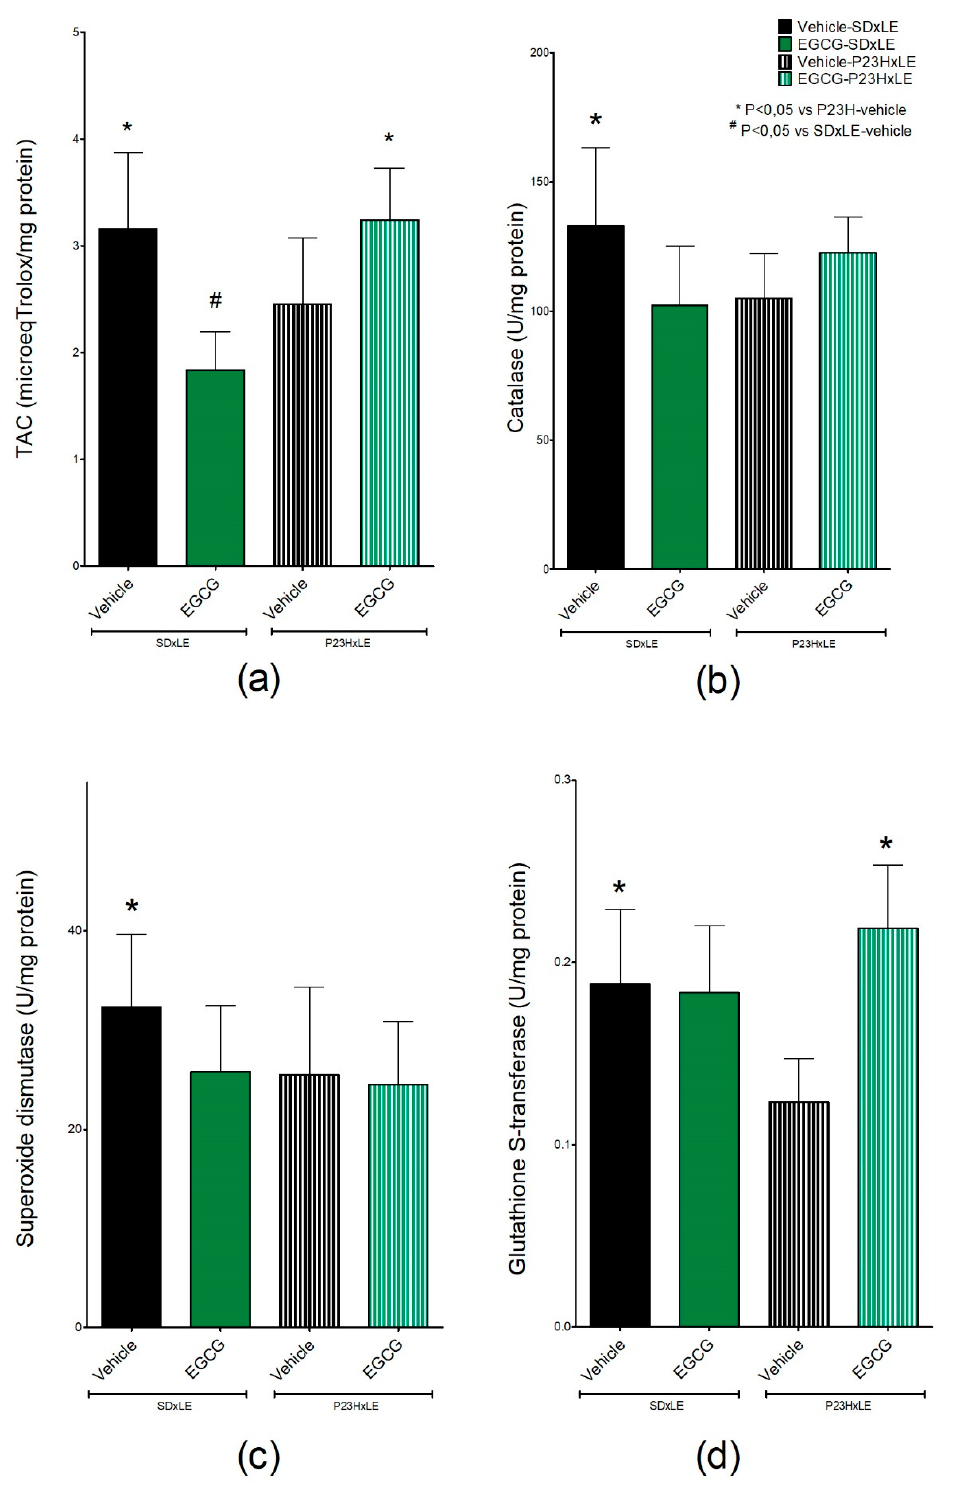
Figure 8. Levels of ( a ) total antioxidant capacity (TAC), ( b ) catalase (CAT), ( c ) superoxide dismutase (SOD), and ( d ) glutathione S-transferase (GST) activity in P23H rats’ livers and SD × LE treatment groups. Epigallocatequin gallate (EGCG). Data are represented as the mean ± standard error ( n = 5 per group). Mann–Whitney U test, * p < 0.05 versus P23H-vehicle animals, # p < 0.05 versus SD × LE animals.